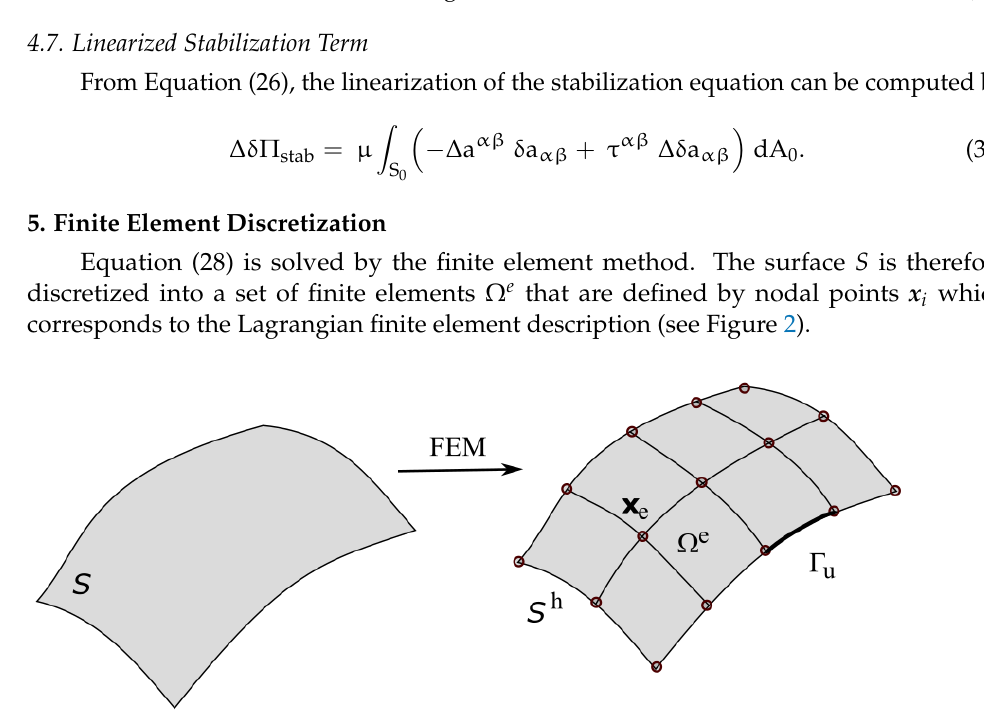
Figure 2. FE discretization of surface 𝑆 .